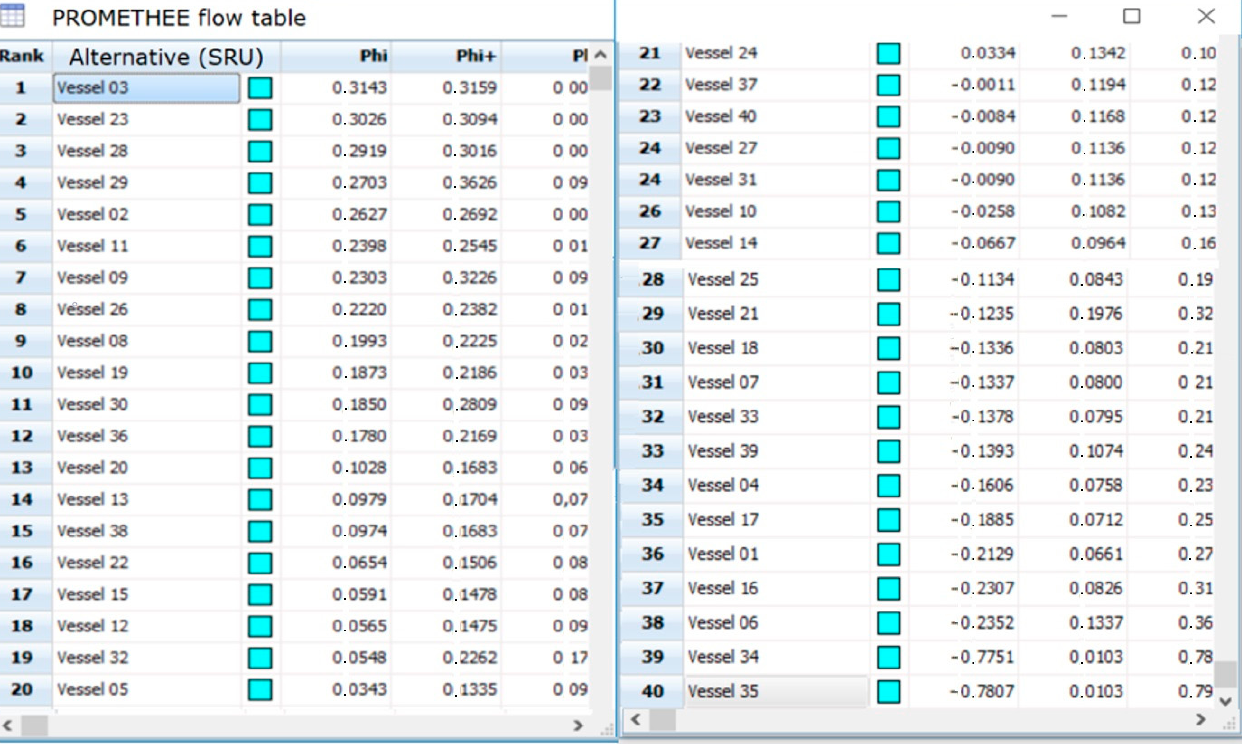
Figure 8. Net flows—a ranking of alternatives (own work on the basis of the Visual Promethee software).